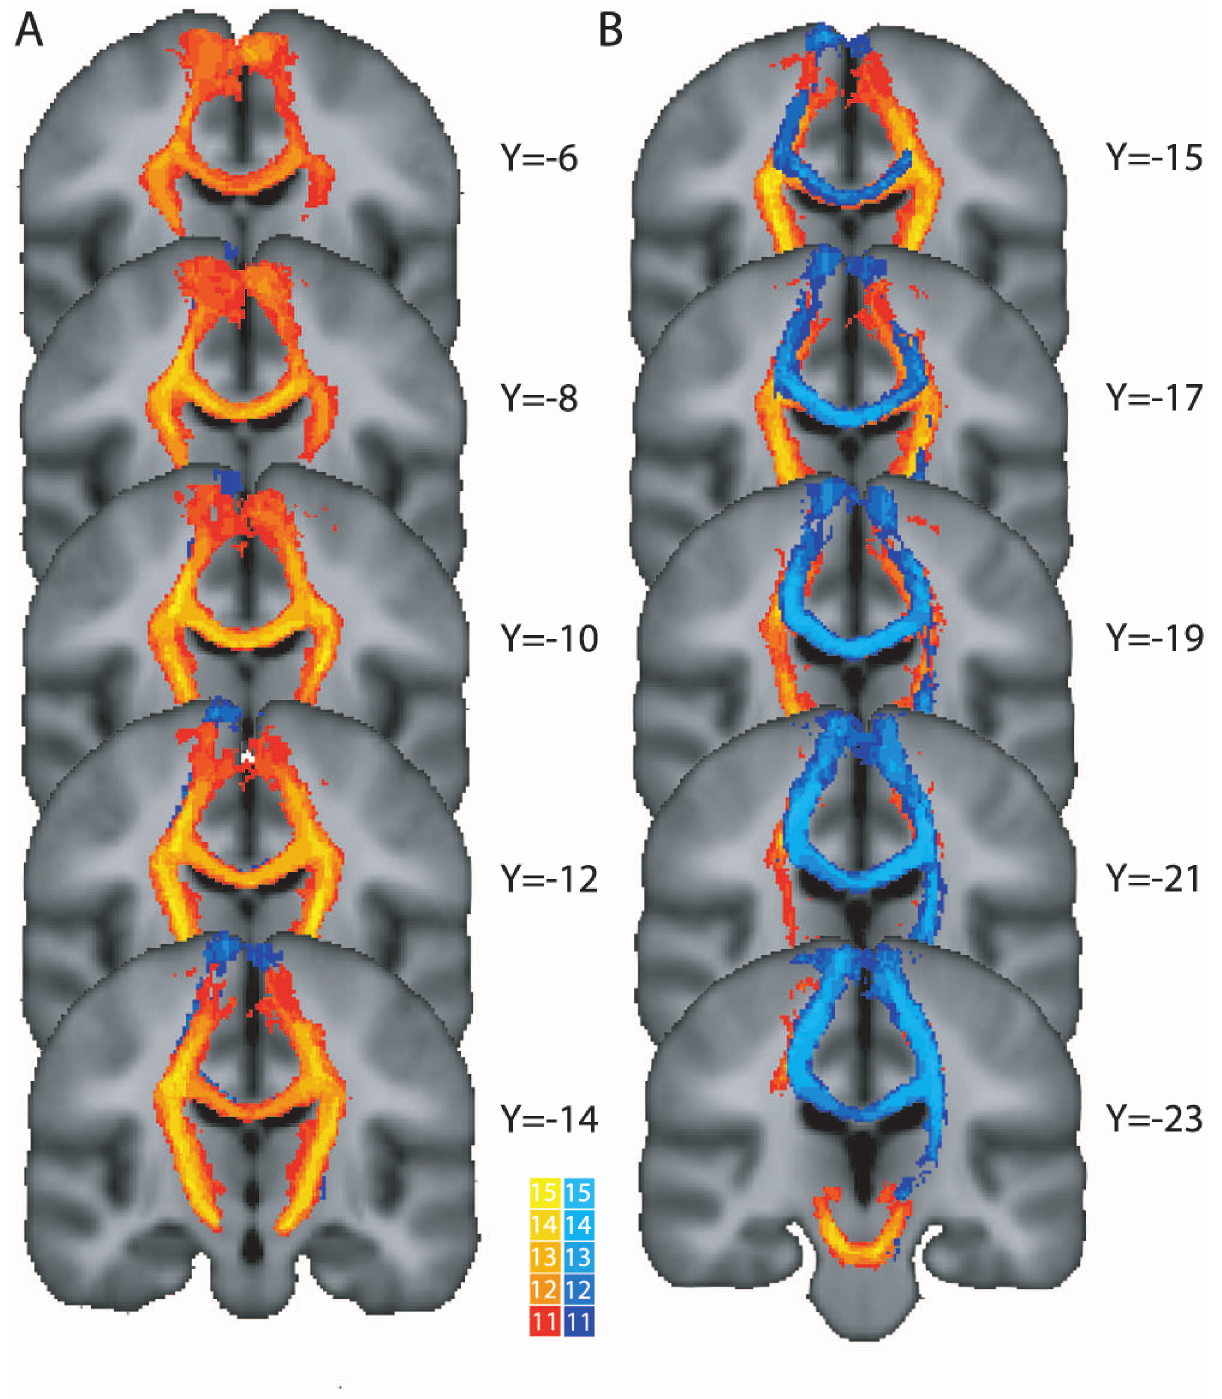
Figure 2. Overlap images for the tracked fibers of hand (A) and leg (B) areas for all subjects superimposed on the Montreal Neurological Institute 152 T1 brain in FSL. The fibers associated with the hand representations are shown in red; the fibers associated with the leg representations are shown in blue. The colour bars indicate the degree of overlap across subjects for each pathway. The sagittal coordinates (Y) are given in standard space (mm) and the image is displayed in the radiological convention. RMT) on MEP RCs and on background EMG activity to examine active conditions, stepwise linear regression analysis was employed the increase of M1 ipsilateral activity in the tasks. To investigate the for the FCR CMFs and TA CMFs separately with the same relationship between the mean FA values in the CMFs and the parameters, the change in MEPs during FCR task and TA task change in MEPs recorded from the left target muscle during the recorded from the left FCR. Age and sex were included as